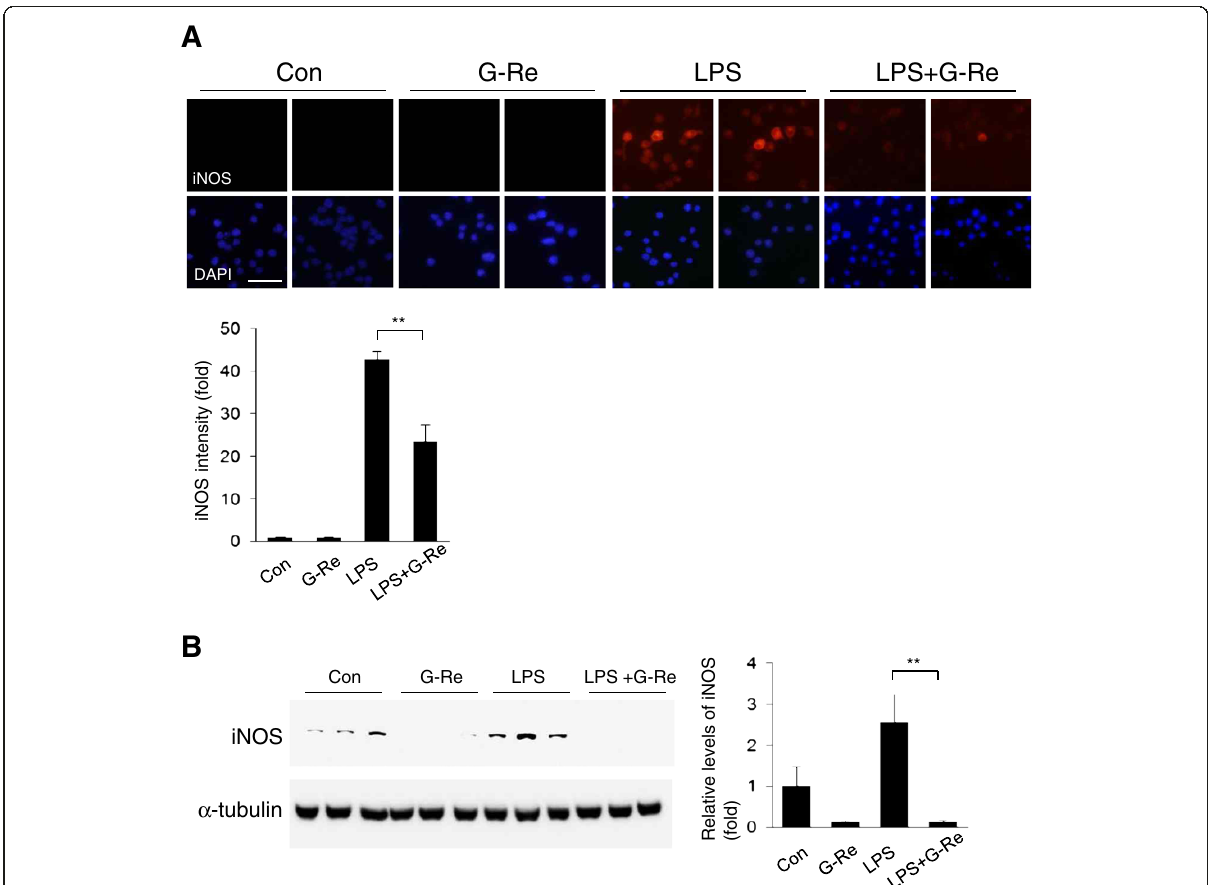
Figure 3 Ginsenoside-Re attenuates the expression levels of iNOS proteins in LPS-induced BV2 microglial cells. ( A ) BV2 cells were pretreated with 2 μ g/ml of G-Re for 1 h, and then stimulated with 1 μ g/ml LPS for 18 h in the presence or absence of 2 μ g/ml G-Re. Cells were visualized using immunofluorescence microscopy with antibody against iNOS. Quantification of iNOS expression density by Image J is shown on the right. (n = 5 for each of the four groups.) (bars: 50 μ m.) * p < 0.05, ** p < 0.01. ( B ) Western blots were performed using an antibody against iNOS. The loading control for the cell lysates was determined by re-probing the membranes with α -tubulin antibody. The values shown are the mean ± S.E.M. of data obtained from three independent experiments. * p < 0.05, ** p <